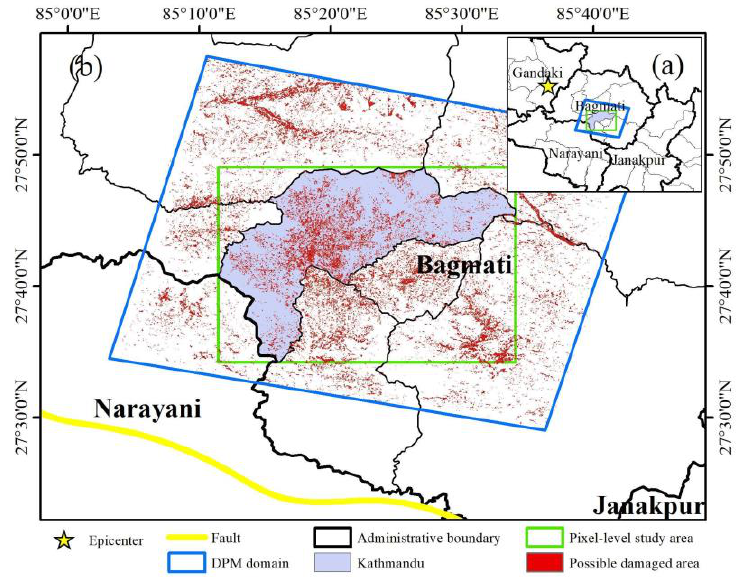
Figure 3. ( a , b ) Damage proxy map and pixel-level study area. The green box is the analysis area at the pixel level, including Kathmandu. The red position indicates where there may be building damage. The yellow line indicates the seismogenic fault.